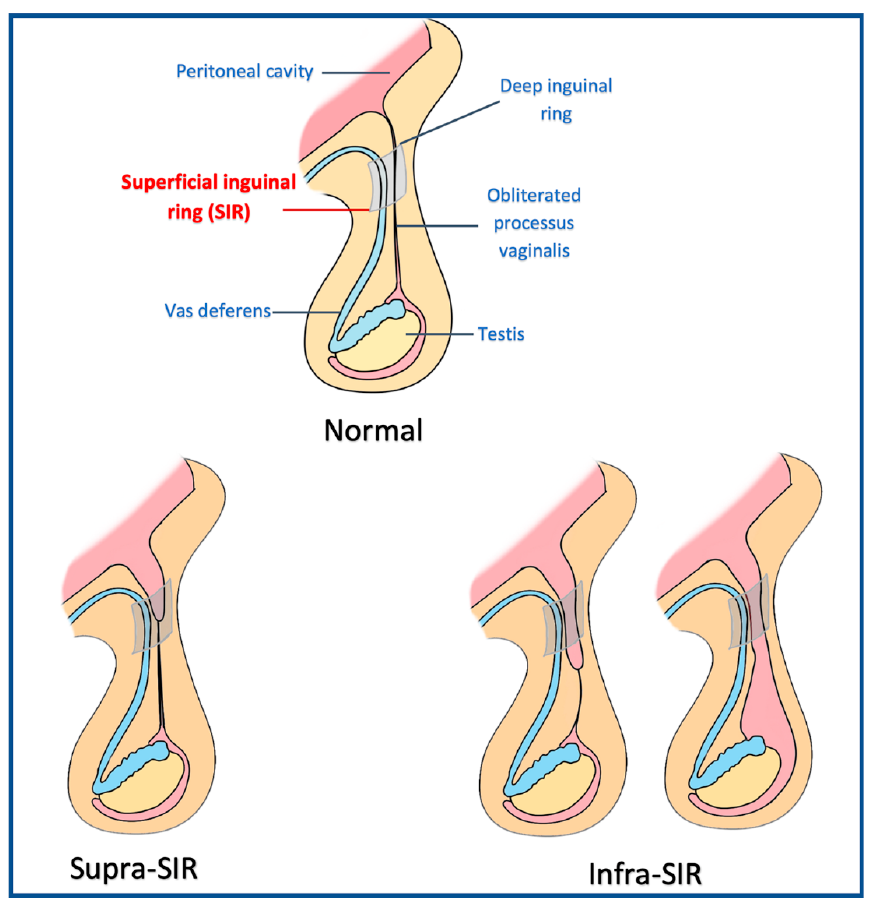
Figure 1. The size of the inguinal sac. The superficial inguinal ring (SIR) was defined as a boundary. The inguinal sac beyond the SIR or into the scrotum was the infra-SIR type, while the hernia sac above the SIR was the supra-SIR type.